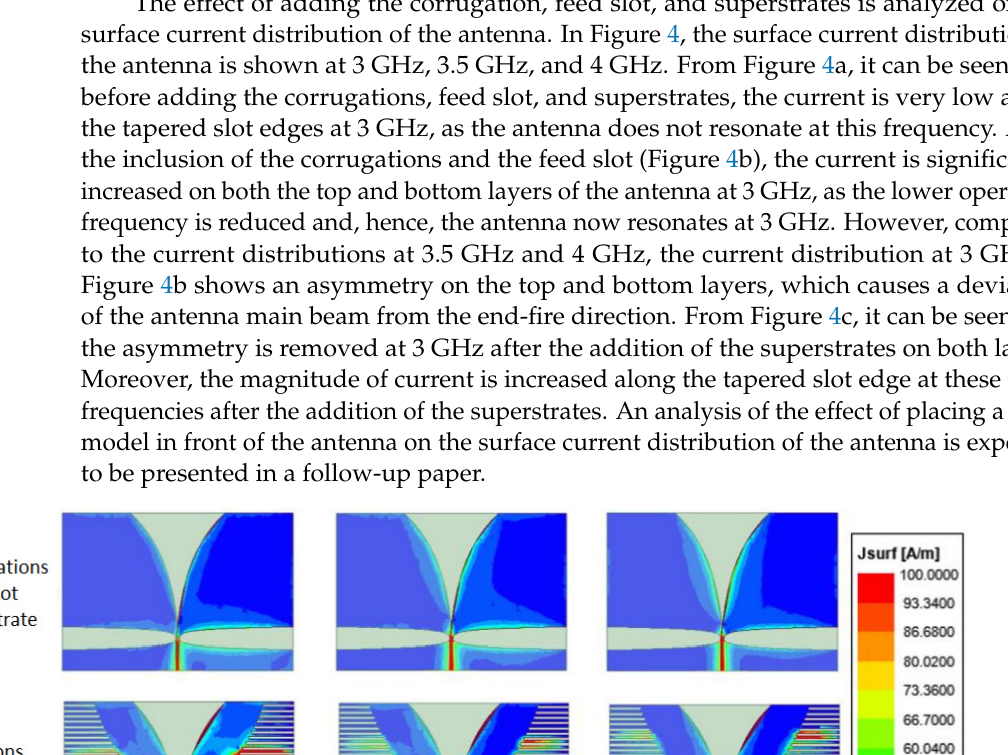
Figure 3. Reflection coefficient (S 11 ) of the proposed antenna 1.